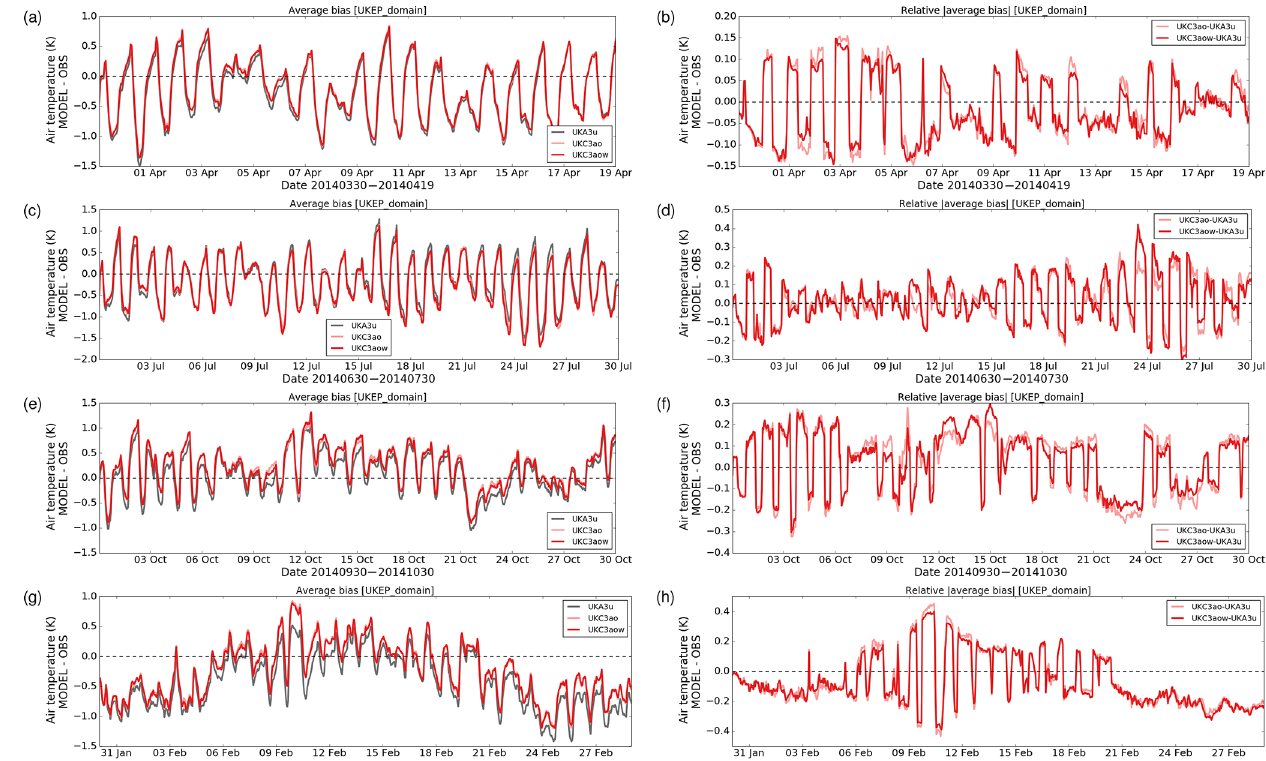
Figure 12. (a, c, e, g) Time series of average model–observation (MODEL–OBS) bias of 1.5m air temperature across all observing sites for each simulation for July, April, October 2014 and February 2015, respectively. (b, d, f, h) Differences in absolute | MODEL–OBS | bias for each simulation period relative to UKA3u. A negative relative | average bias | indicates the coupled system to have a lower average absolute bias across all observation sites than the control. Note that plots have different scales across the different months evaluated, and observations are compared with a nearest neighbourhood mean of 3 by 3 model grid